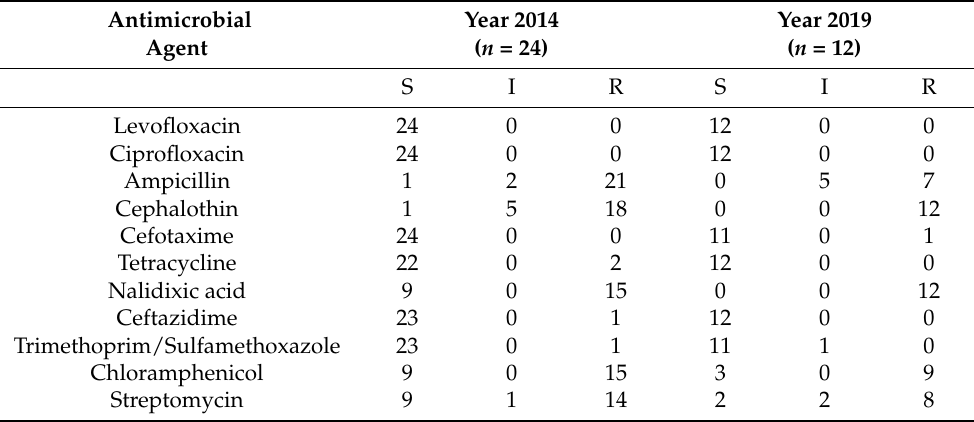
Table 8. Antimicrobial susceptibility/resistance of Y. enterocolitica 4/O:3 isolates from big inte- grated farms.